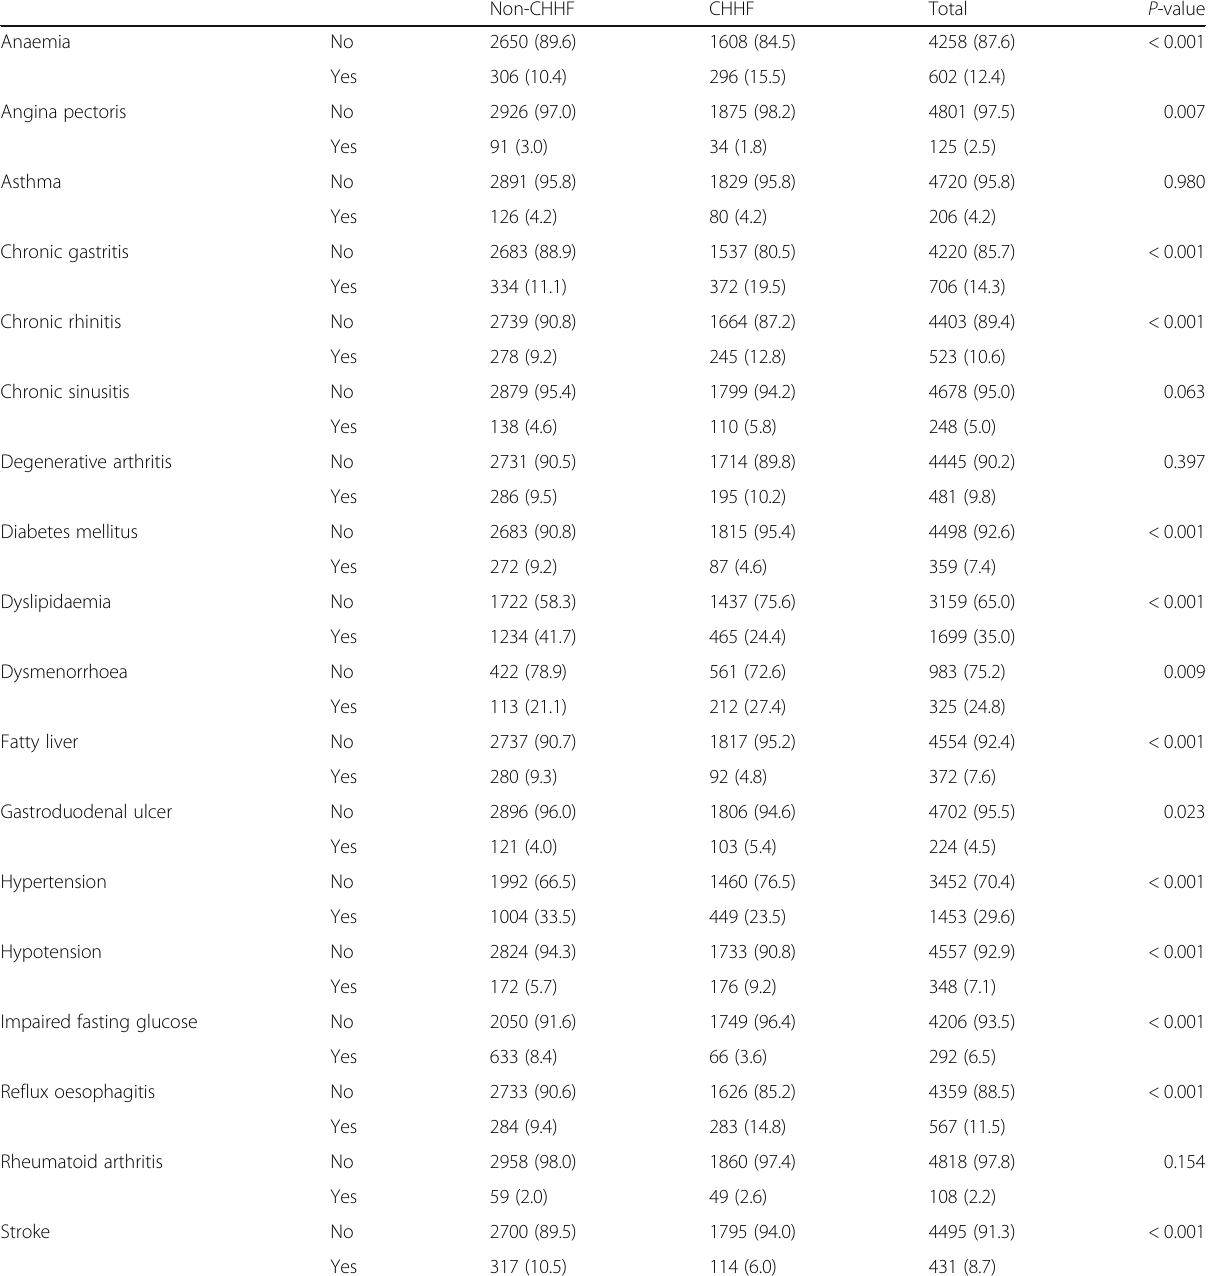
Table 2 Disease frequencies in the CHHF and non-CHHF groups Non-CHHF CHHF Total P